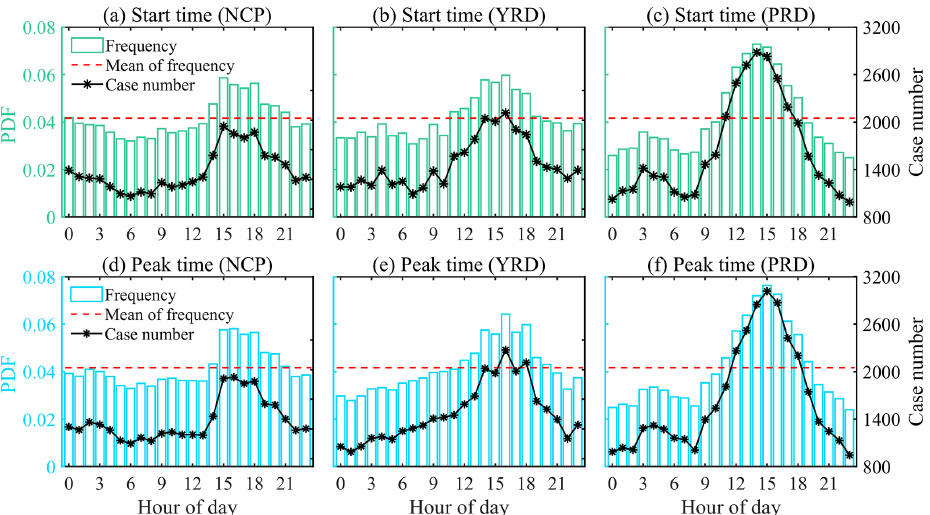
Figure 4. The probability density functions (PDFs) of the start time ( a–c , green) of precipitation and the peak time ( d–f , blue) of precipitation in June–August from 2015 to 2020 over the three study regions. The NCP, YRD, and PRD represent the North China Plain, Yangtze River Delta, and Pearl River Delta, respectively. The black line represents the sample number of precipitation events at the corresponding time, and the red dotted line is the average daily precipitation